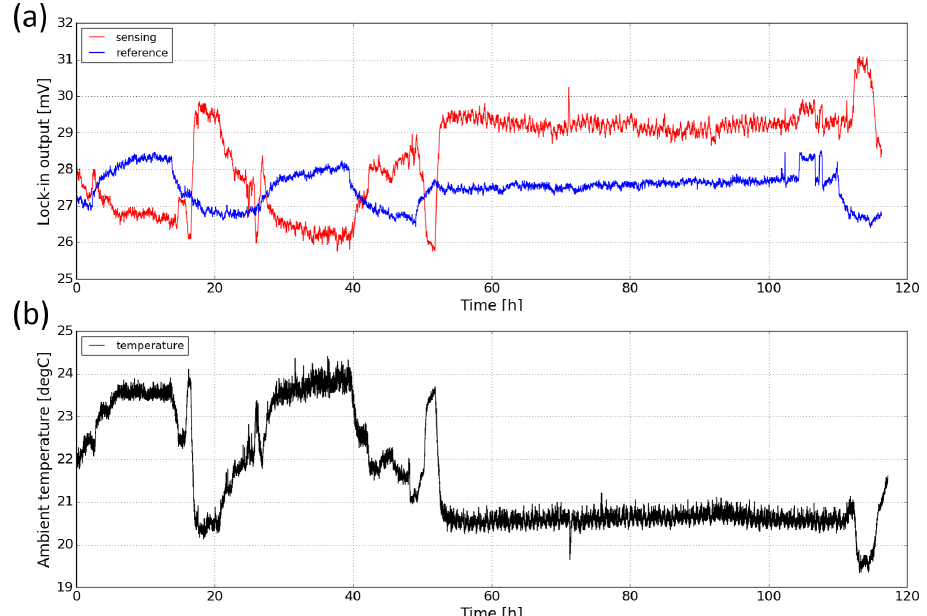
five days. ( b ) Ambient ∼